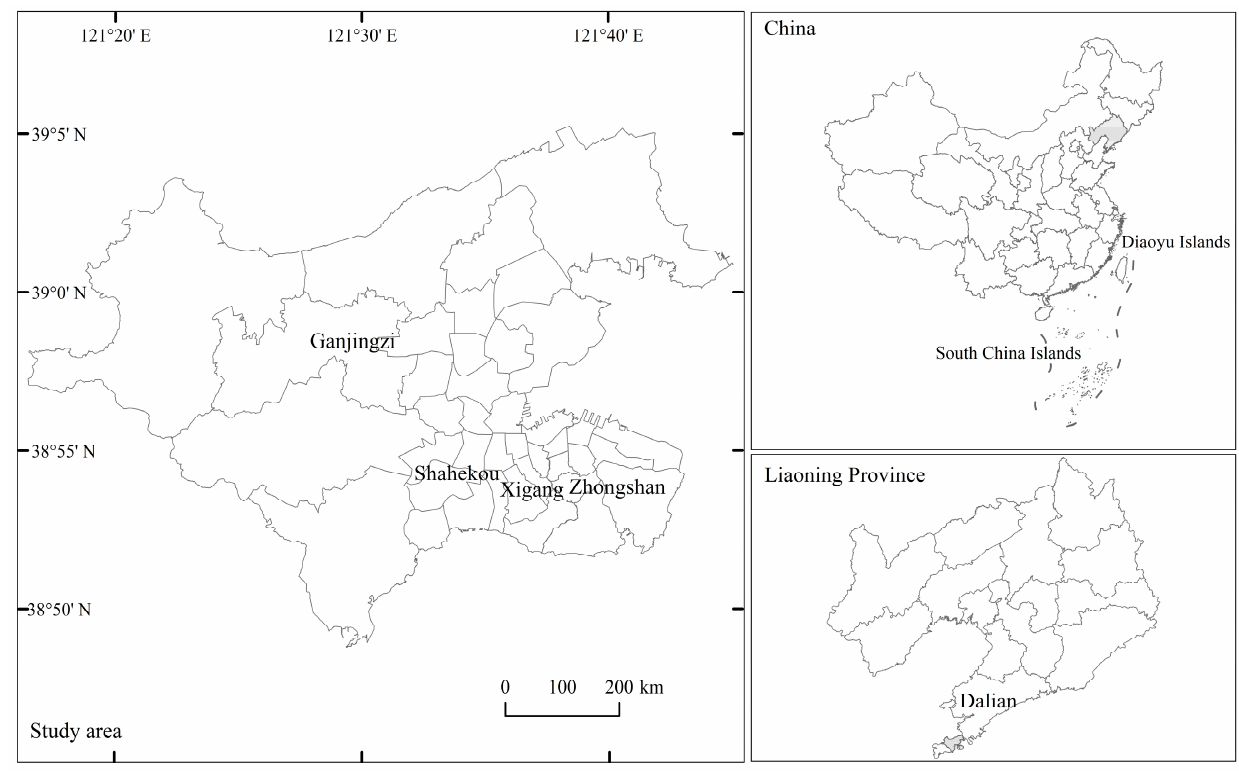
Figure 2. Location of the study area.